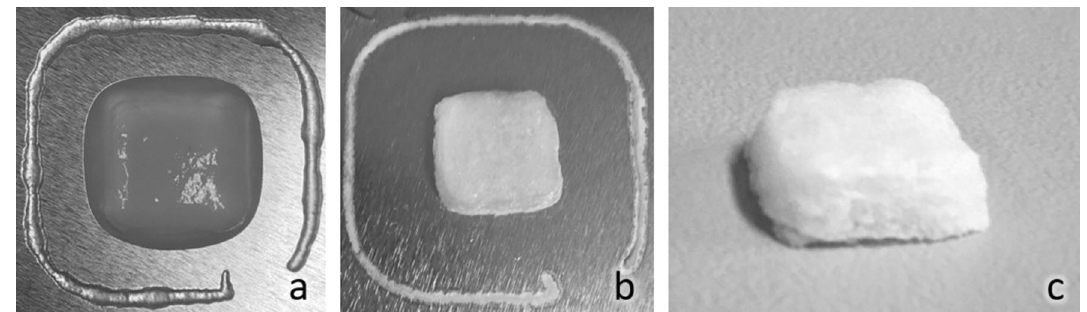
Figure 2. Representative images of printed TOCNF–Mg 2+ -gel (1:1:25, 2 × G). Gel cube ( a ) (10 × 10 × 5 mm) after printing in wet state, and ( b , c ) after